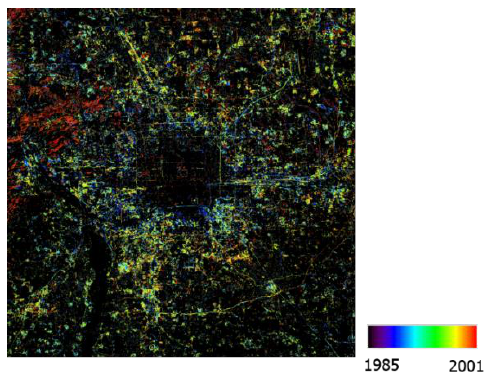
Figure 2. Annual urban built-up change area result